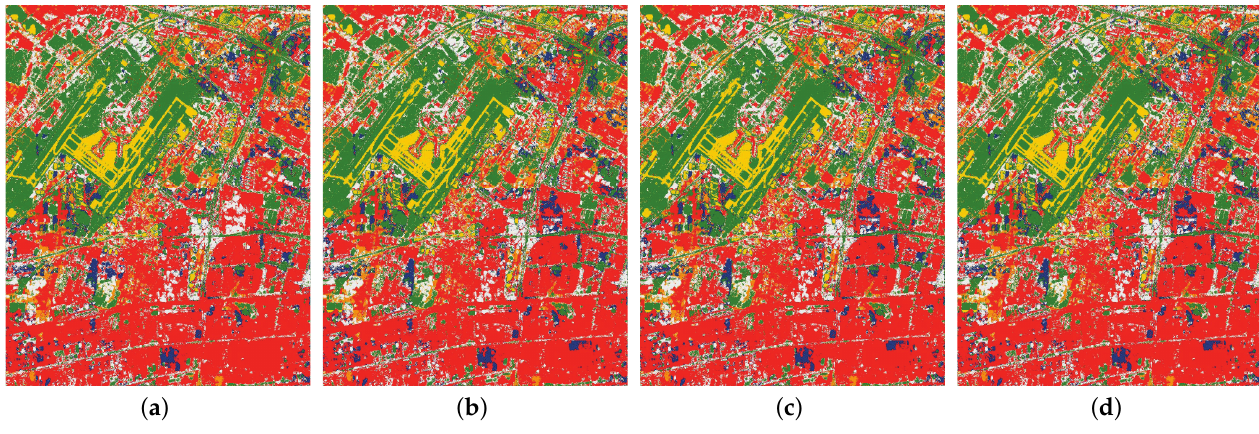
Figure A9. Classification results with different block sizes. ( a ) Result with block size as 67. ( b ) Result with block size as 80. ( c ) Result with block size as 100.